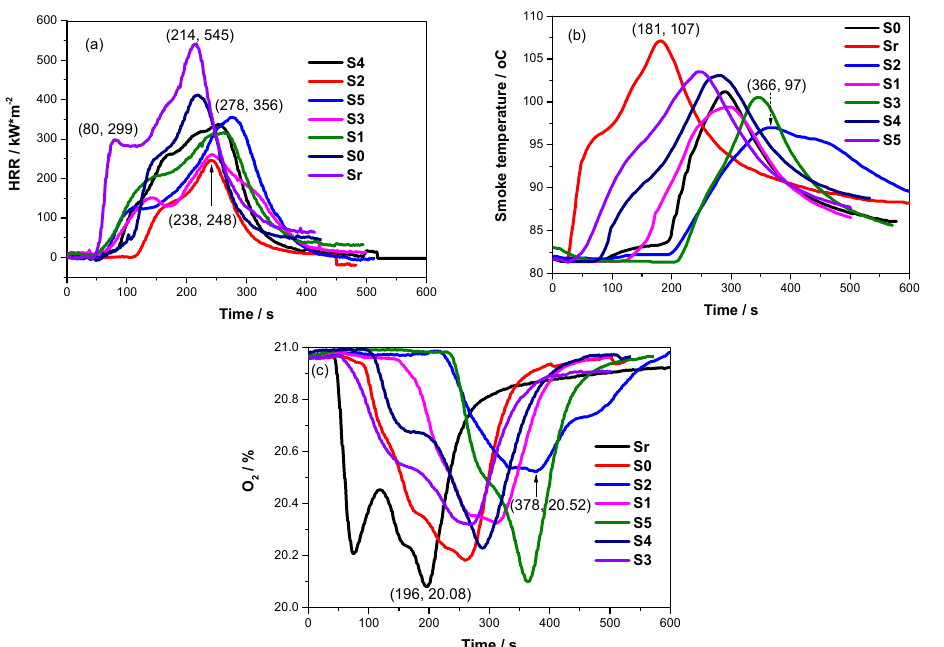
Figure 1. Real-time combustion parameters of samples including ( a ) heat release rate (HRR), ( b ) smoke temperature, and ( c ) O 2 concentration.